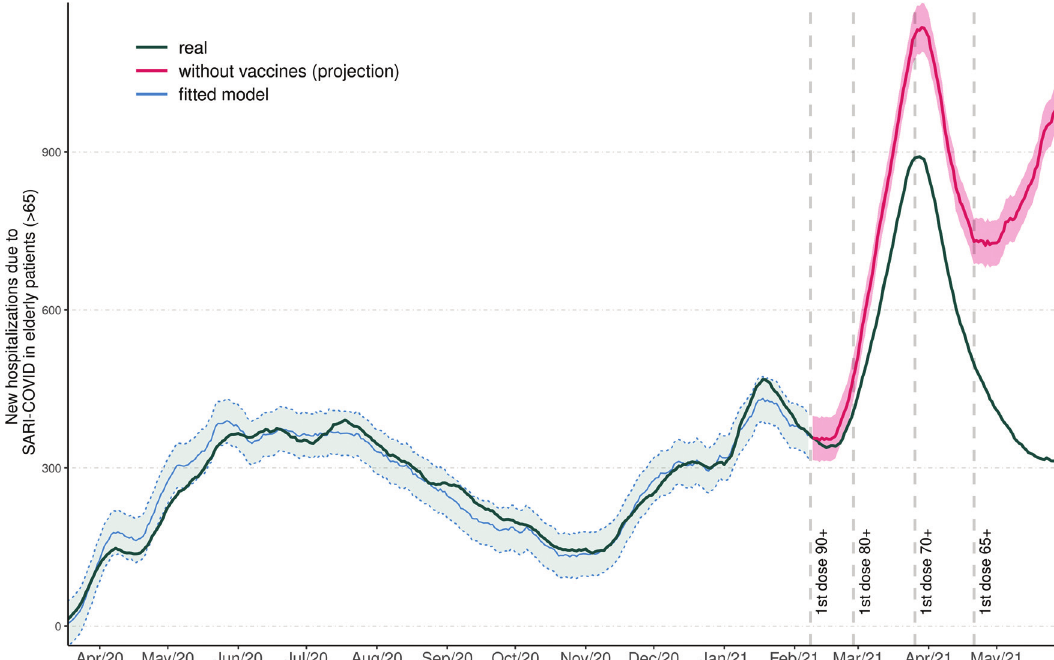
Figure 1 - Number of hospitalizations due to SARI-COVID in patients aged 4 65 years (dark green), fitted pre-vaccination model (blue), and estimated counterfactual curve for the setting without vaccines